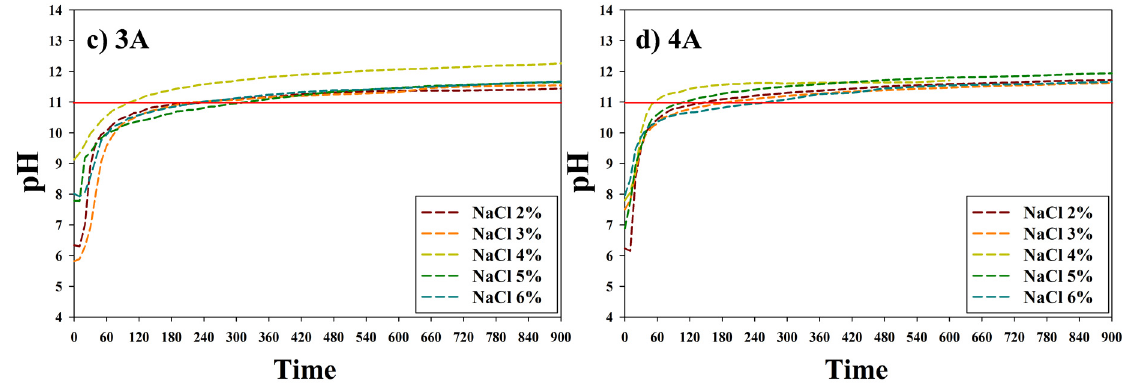
Figure 3. Result of the electrolysis of NaCl solution. ( a ) 1A condition; ( b ) 2A condition; ( c ) 3A condition; ( d ) 4A condition.